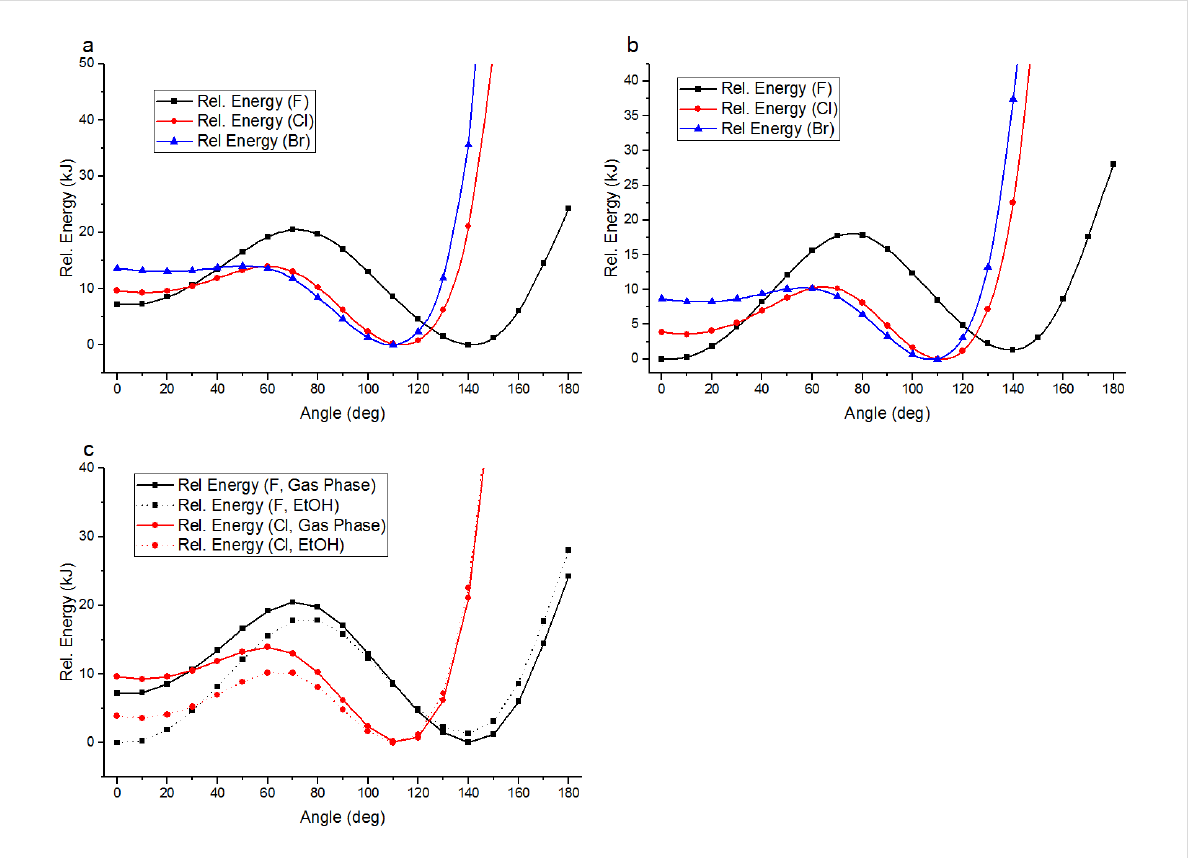
Figure 1: Conformational energy profiles of halogenated acetophenones (a) in gas phase; (b) in EtOH; (c) overlay of gas phase and EtOH for F and